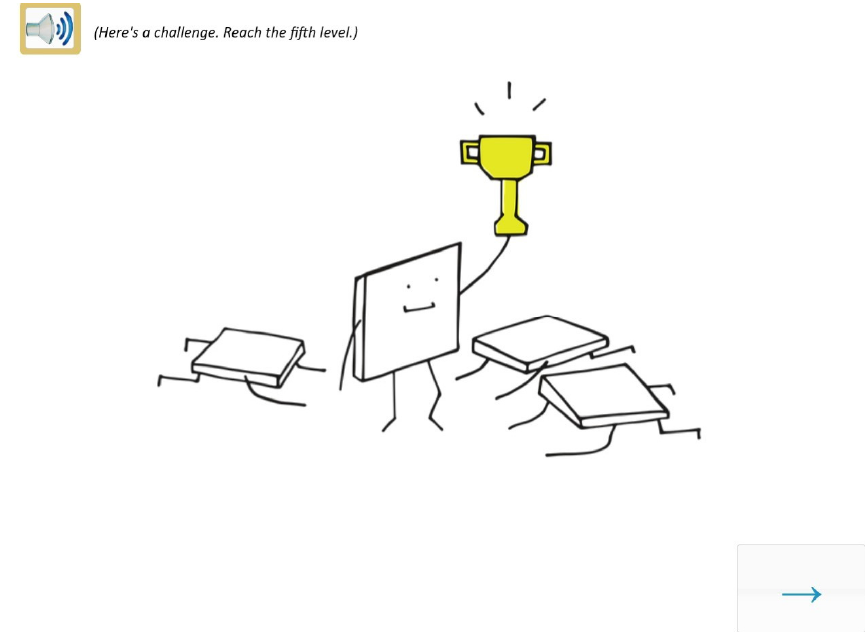
Figure 6. Example of a motivating feedback.